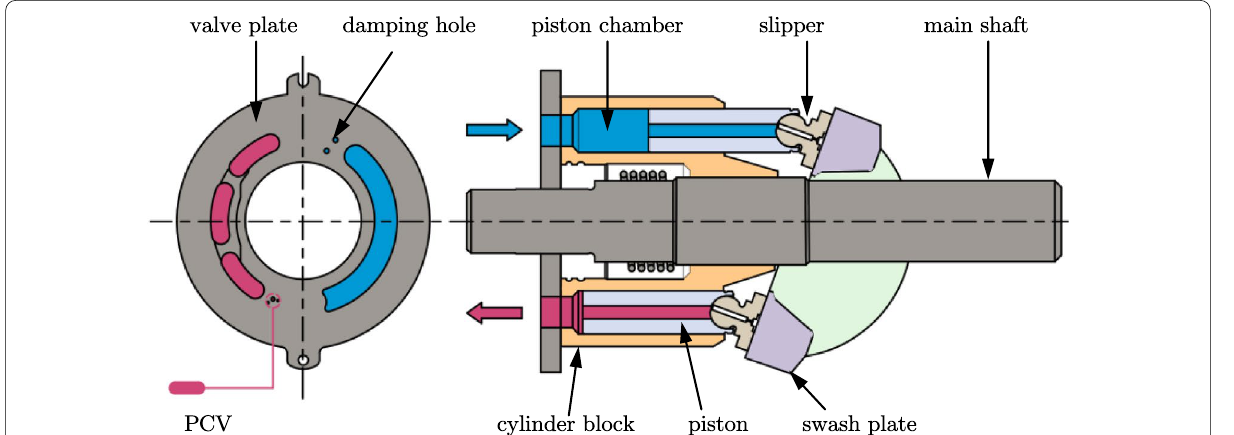
Figure 1 Schematic diagram of the axial piston